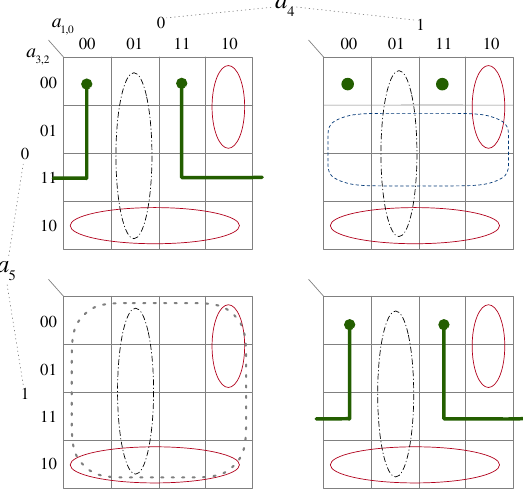
FIG. 4. The Karnaugh map for the recursive construction of the cycle for ( A + 2 ) qubits creates two copies of the A qubit cycle with a gap, isolated by a difference of both new qubits. Solid ovals are the original penalty cover extended over the two new qubits. The upper right subspace contains the two codes used to connect the copies into a new cycle. They are referred to as drill-through codes because they connect the subsequent copies through the isolating layer represented by the upper-right sub- space. The additional penalty cover for the upper right subspace is a set of large subcubes, each covering half the subspace. Code values for a 3,2 and a 1,0 should be applied across the entire